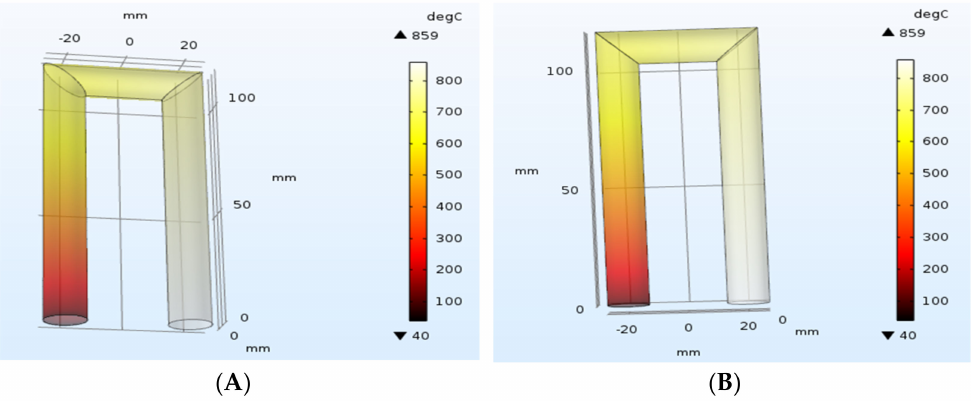
Figure 11. Hot air temperature profile. ( A ) k- ε , ( B ) k- Ω